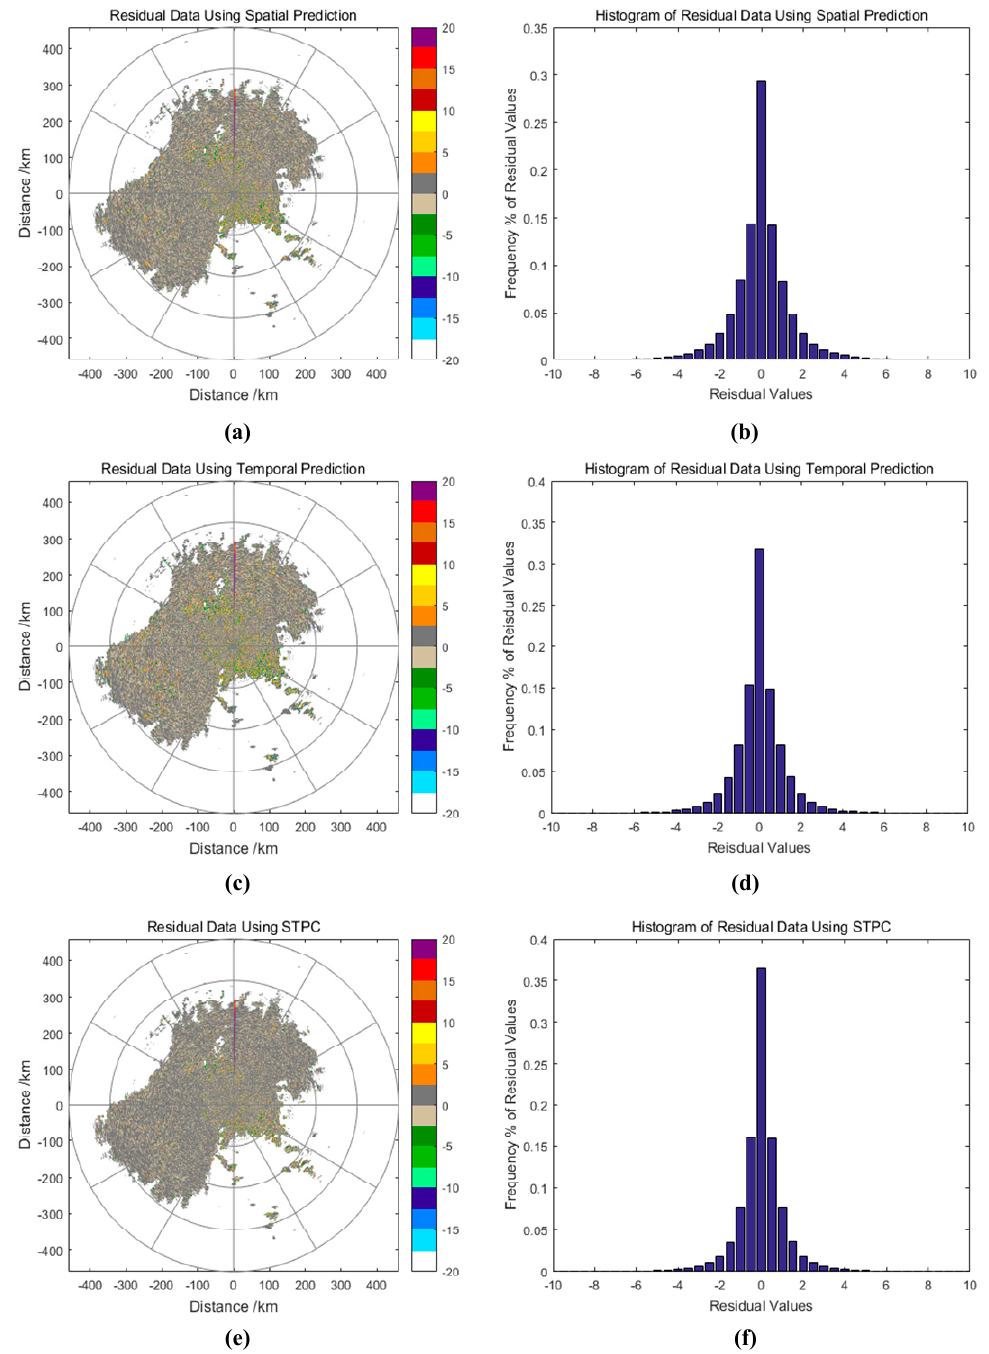
Figure 7. Residual and frequency histogram of range bin values for CINRAD elevation cut using different prediction mode: ( a ) Residual data using spatial prediction; ( b ) frequency histogram of residual data using spatial prediction; ( c ) residual data using temporal prediction; ( d ) frequency histogram of residual data using temporal prediction; ( e ) residual data using STPC; and, ( f ) frequency histogram of residual data using STPC.